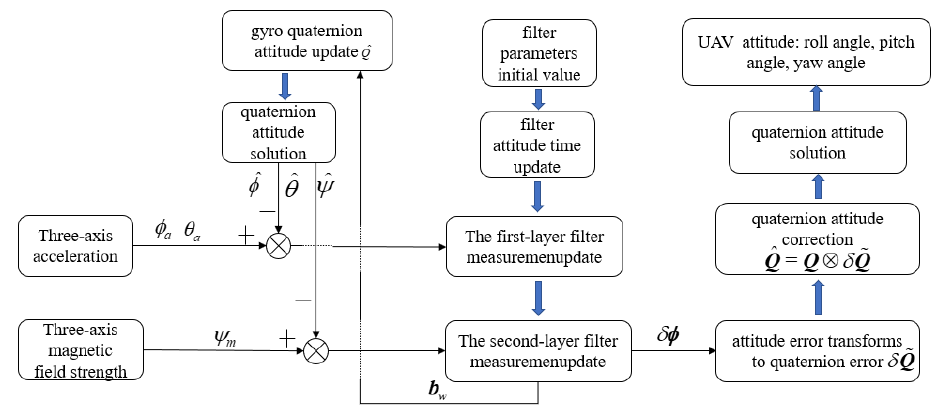
Figure 2. Unmanned aerial vehicle (UAV) attitude filtering diagram.